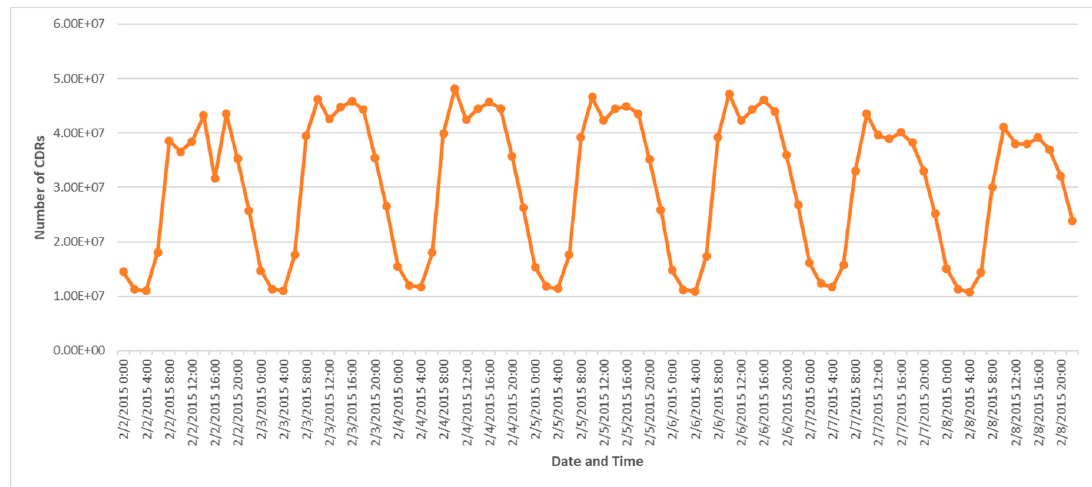
Figure 1. The number of call detail records (CDRs) distributed every 2 h over one week.